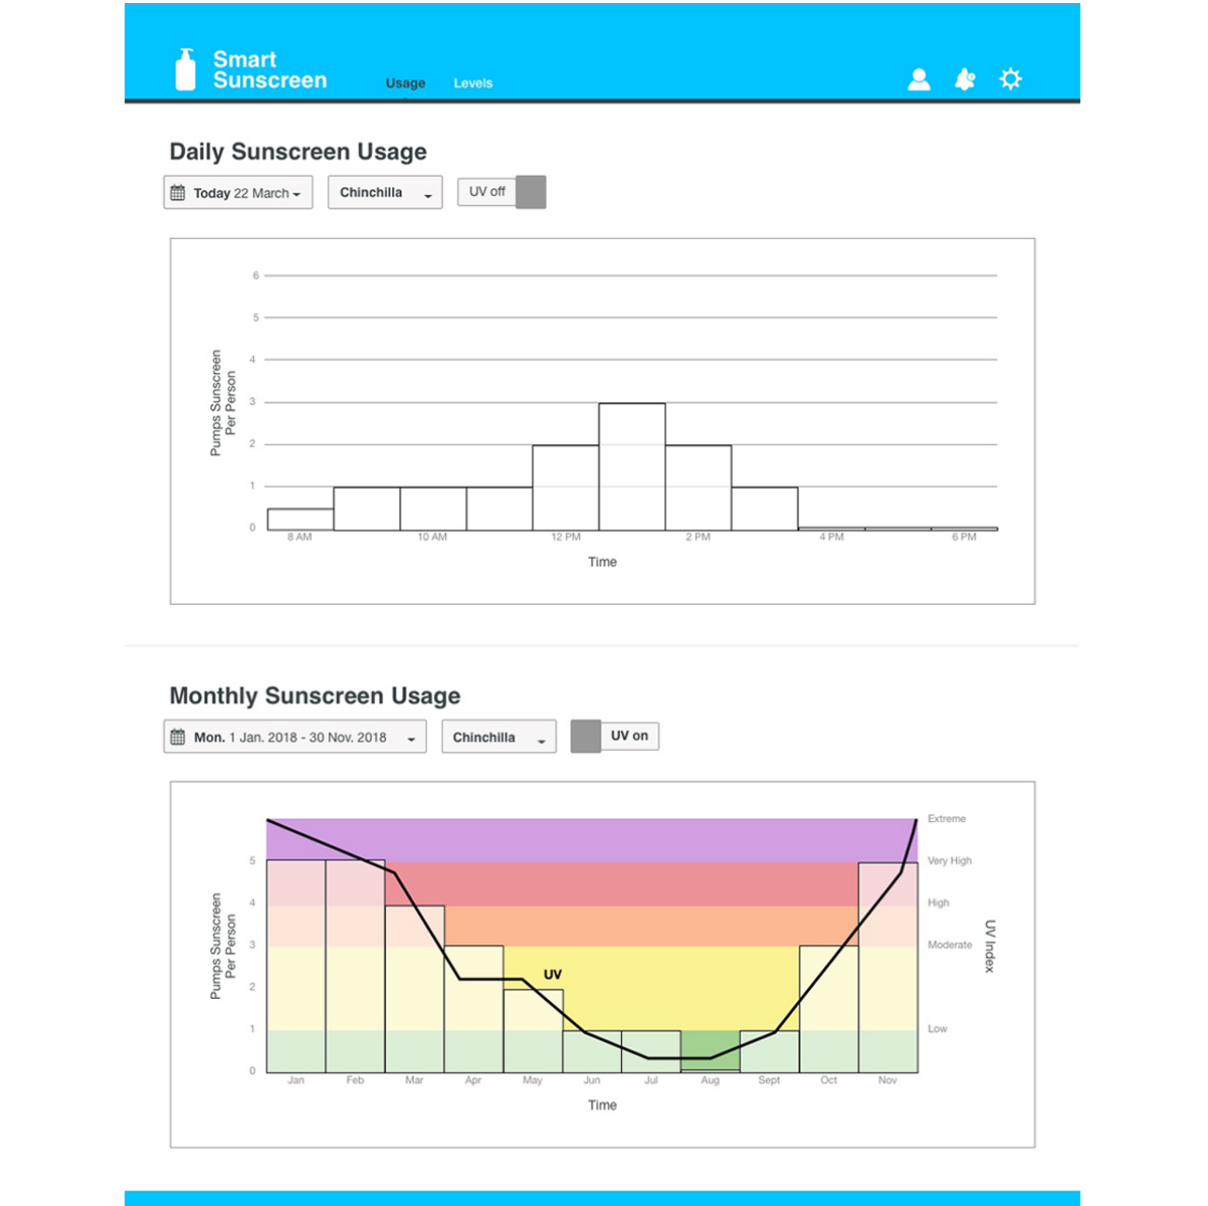
Figure 7. Dashboard infographics communicating smart sunscreen station data, including the daily sunscreen usage per person and the monthly sunscreen usage overlaid with UV index weather